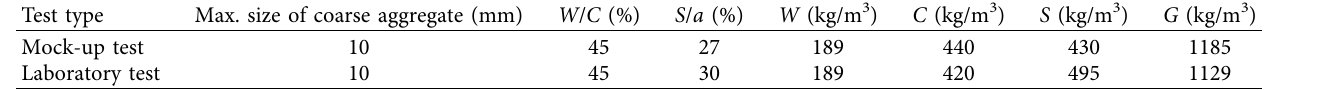
Table 1: Mixture proportions of exposed aggregate concrete overlay in mock-up and laboratory test.